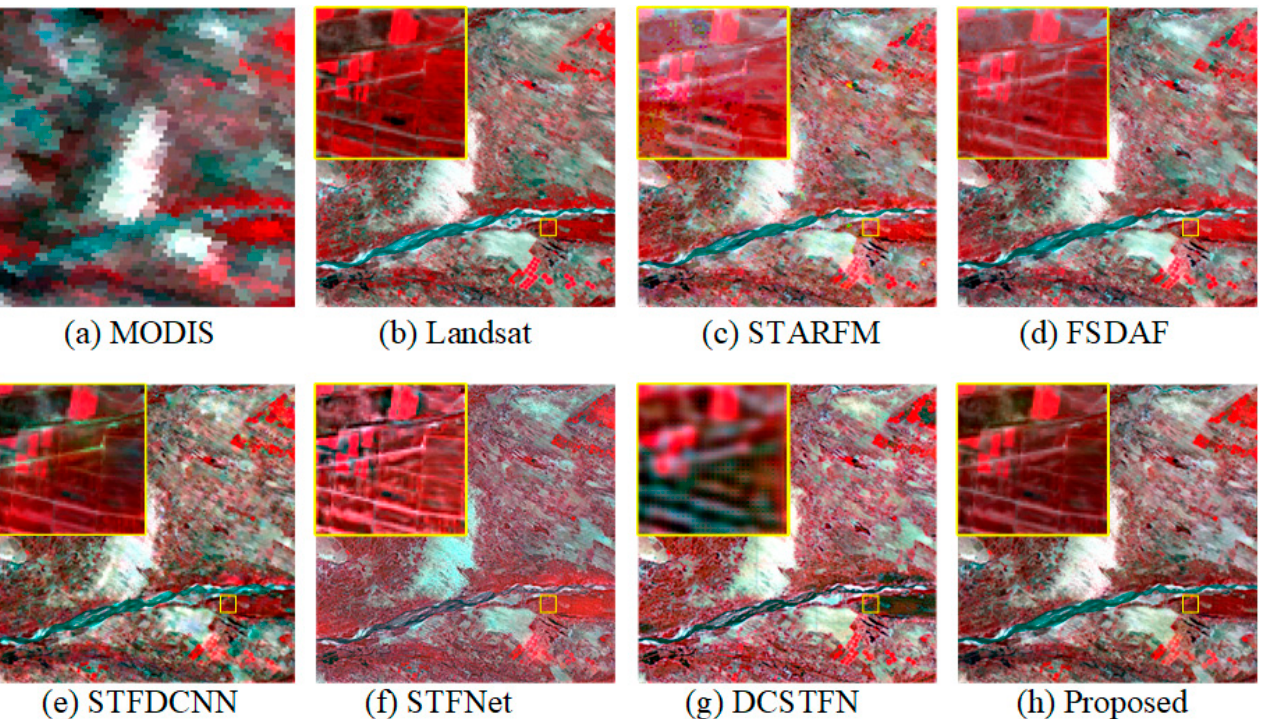
Figure 6. Prediction results of Landsat satellite images (2 March 2005) in LGC dataset. ( a ) is the corresponding MODIS image, ( b ) is the real image, ( c – g ) are the prediction results of STARFM, FSDAF, STFDCNN, StfNet, and DCSTFN models, respectively, and ( h ) is the prediction result of our model.